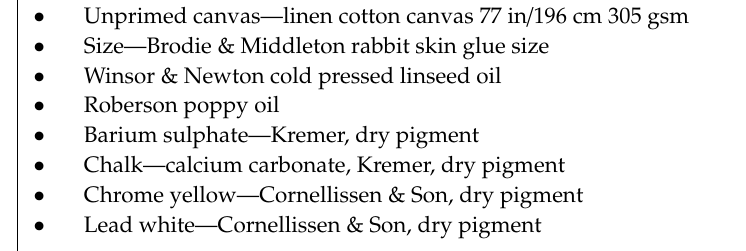
Table 1. Materials used to produce the experimental samples and suppliers of the materials.